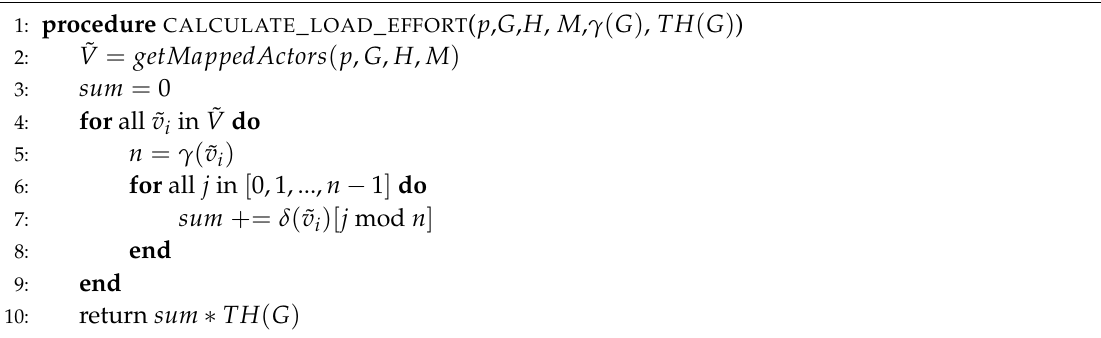
Algorithm 1 Calculating effort function e f load ( p ) capturing the load of a processor core. p